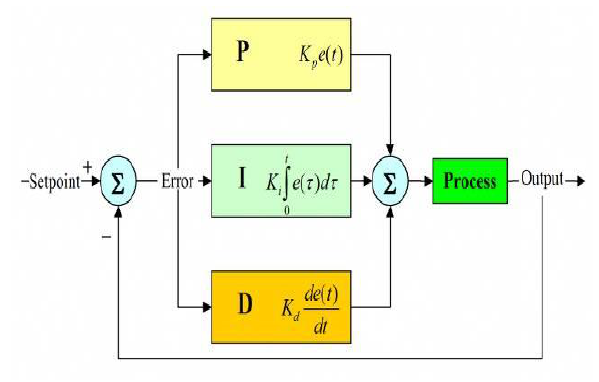
Figure 2.3. Block Diagram Of The PID System